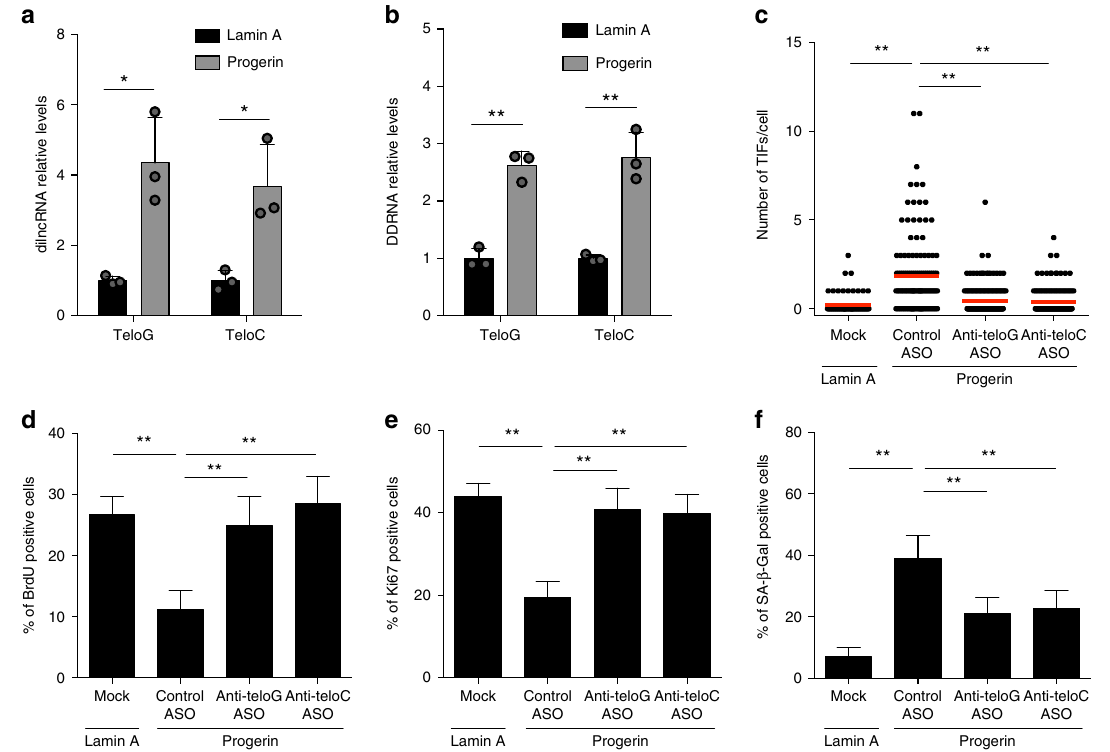
Fig. 1 Inhibition of progerin-induced tncRNAs reduces proliferative defects and cellular senescence. a , b Total cell RNA was puri fi ed from human fi broblasts transduced with a retroviral vector expressing either lamin A or progerin. a tdilncRNAs were quanti fi ed by strand-speci fi c RT-qPCR. Error bars represent s. d., n = 3 independent experiments. * P < 0.05; two-tailed Student ’ s t test. b tDDRNAs were quanti fi ed by miScript PCR ampli fi cation of gel-extracted small RNAs (shorter than 40 nucleotides). Error bars represent s.d., n = 3 independent experiments. ** P < 0.01; two-tailed Student ’ s t test. c Human fi broblasts were transfected with the indicated ASOs and 24 h later transduced with a retroviral vector expressing either lamin A or progerin. Fixed cells were stained for 53BP1 and TRF2 to quantify telomere dysfunction-induced foci (TIFs) as determined by 53BP1 co-localizing with TRF2. n = 3 independent experiments. ** P < 0.01; one-way ANOVA with multiple-comparison post-hoc corrections. At least 100 cells per sample were analyzed. d – f Cells from experiments shown in c were pulsed with BrdU for 8 h and stained for BrdU ( d ), Ki67 ( e ), and SA- β -Gal activity ( f ). Bar graphs show the percentage of positive cells